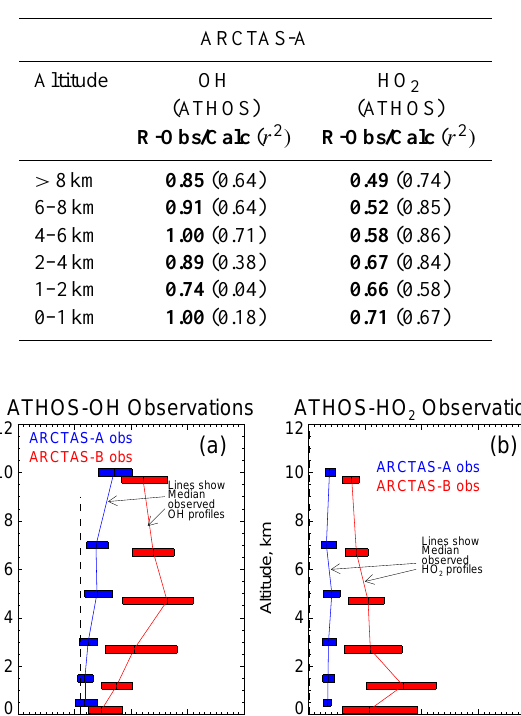
Table 6. Median Observed-to-Calculated Ratios and ( r 2 ) for HO x